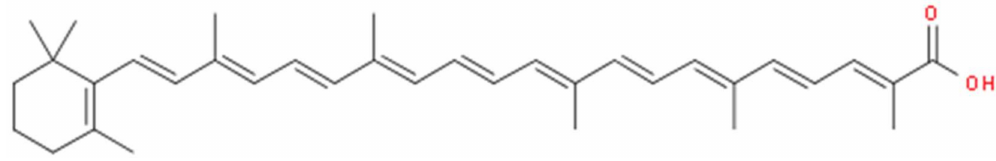
Figure 8. Structure of neurosporaxanthin. Source: Royal Society of Chemistry